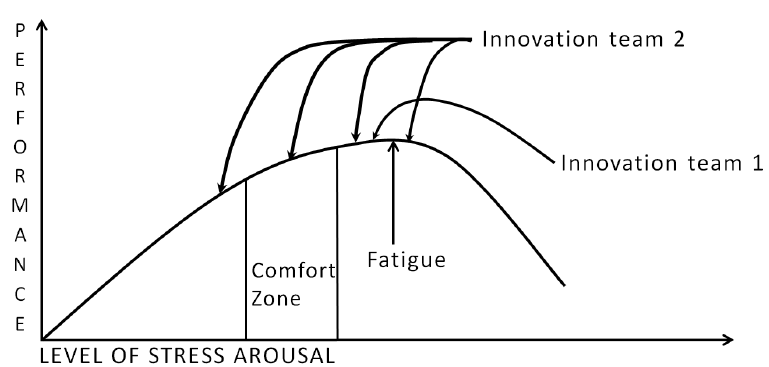
Fig. 10. Stress level of different participants in the innovation